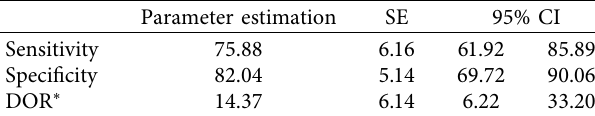
Figure 2: Summary ROC plot of sensitivity and specificity of EIT. Table 3: Meta-analysis of diagnostic accuracy.